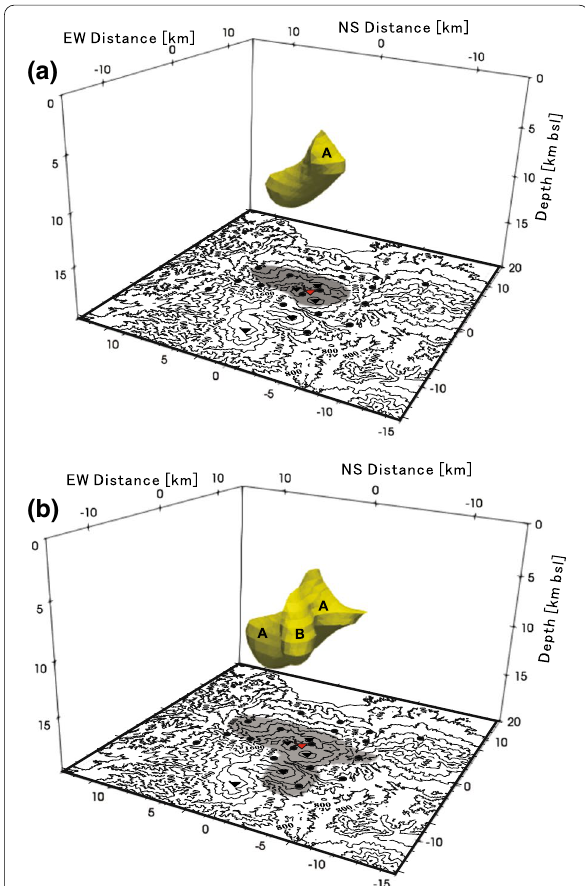
Fig. 13 Perspective view of isosurface of a 1 and b 3 Ωm in the depth range from 3 to 15 km bsl. The bottom of each figure shows observation site (solid circle), edifice (solid triangle), surface topography (black contour line), and the vertical projection of the isosurface (gray shade)